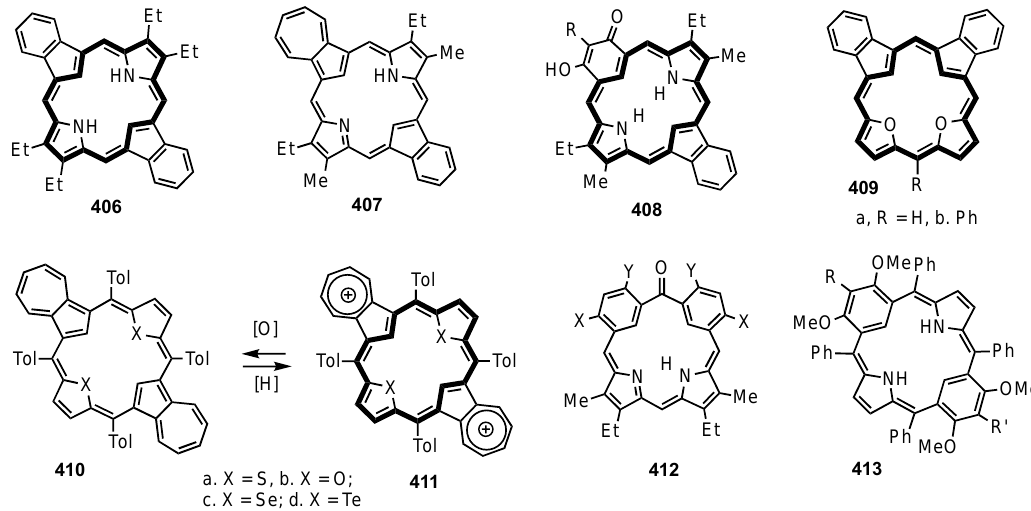
Figure 10. Selected dicarbaporphyrinoid systems.